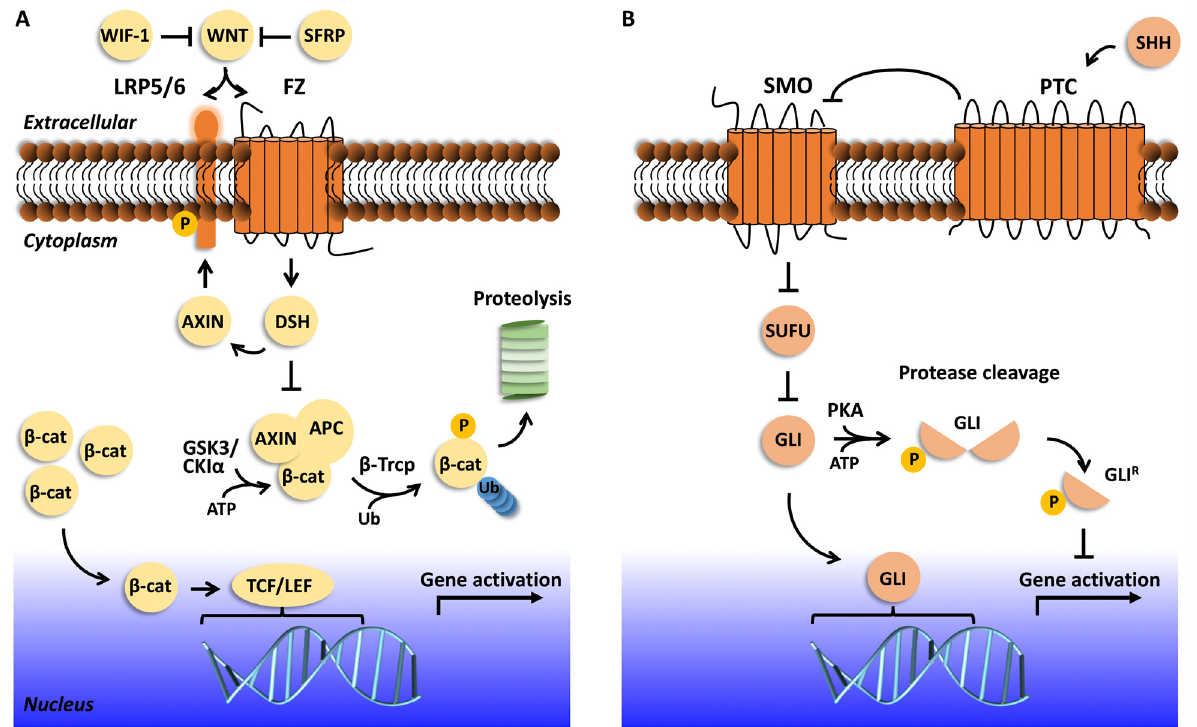
Figure 2. WNT and SHH signaling pathways. ( A ) The WNT signaling pathway is mediated by the receptor Frizzled (FZ) and single-pass low- density lipoprotein receptor-related protein 5 or 6 (LRP5/6). In the pathway’s “off” state (in the event of low, no, or WNT ligand function inhibited by WNT inhibitor factor 1 [WIF-1] or secreted frizzle-related protein [SFRP]), β -catenin ( β -cat) is targeted for phosphorylation by glycogen synthase kinase 3 (GSK3) and casein kinase I alpha (CKI α ), aided by proteins AXIN and adenomatous polyposis coli (APC). β -catenin is then ubiquitinated and targeted for proteolysis by the proteasome. In the pathway’s “on” state, WNT ligand is recognized by FZ and LRP5/6, and LRP5/6 is phosphorylated. The WNT-FZ-LRP5/6 trimeric complex triggers the recognition of Dishevelled (DSH) and AXIN. β -catenin is not phosphorylated, translocates to the nucleus, and functions as a transcriptional coactivator to activate TCF/LEF family transcription factors. Prominent drug targets that aim to regulate WNT-responsive gene expression 22 include those that target (1) extracellular events, such as recognition of WNT by FZ and/or LRP5/6 (vantictumab and ipafricept), (2) cytoplasmic events, such as inhibition of DSH or stabilization of the AXIN/APC interaction (IWR-1; XAV939; 3289-8625; FJ9; NSC 668036; JW74), and (3) transcriptional activation, such as perturbing β -catenin function (PFK115-584; CGP049090; iCRT-3, -5, and -14; PRI-724). There are still other drugs that target events involved in WNT secretion to the extracellular space as well as other enzymes that regulate the pathway, but they are not shown in this schematic. Ub, ubiquitin. ( B ) The sonic hedgehog (SHH) pathway is mediated by the receptors Smoothened (SMO) and Patched (PTC). In the pathway’s “off” state (in the event of low or no SHH ligand), SMO transport from intracellular vesicles to the membrane and its activity at the membrane are inhibited, in part by PTC. Members of transcription factor family GLI are inhibited by suppressor of fused (SUFU). Protein kinase A (PKA) phosphorylates the GLI transcription factors, which undergo proteasomal cleavage to yield a functional repressor form (GLI R ). GLI R translocates to the nucleus and inhibits target gene expression. In the pathway’s “on” state, SHH binds to and inhibits PTC and SUFU is inhibited. SMO levels at the membrane increase, leading to activation of GLI transcription factors, which translocate to the nucleus to activate SHH-responsive genes. Prominent drug targets that aim to regulate SHH-responsive gene expression 13 include those that target (1) extracellular events, such as SMO function, including by inhibition of SHH (purmorphamine, cyclopamine, vismodegib 12 ; sonidegib or Odomzo®, jervine; saridegib,